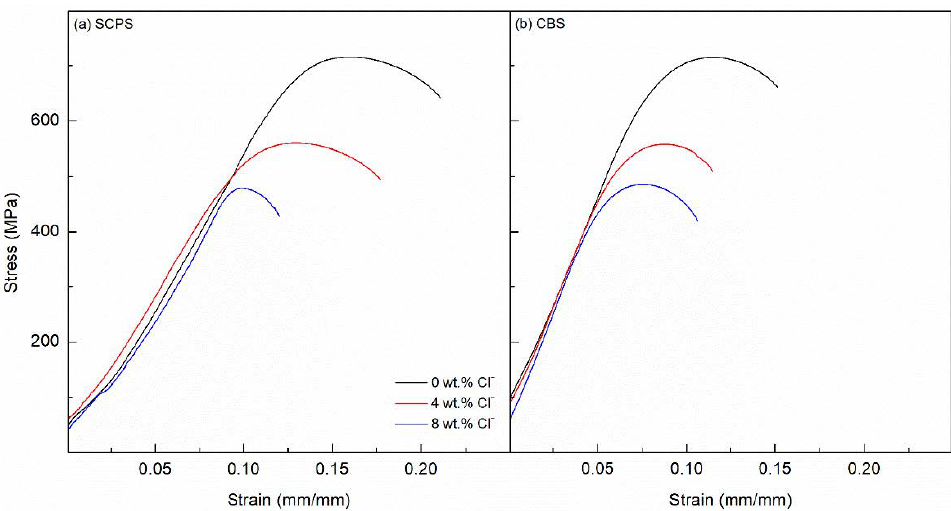
Figure 1. Microstructural characterization of as-received UNS S32205 reinforcement: ( a ) micrograph of the rolling direction ×50, and ( b ) XRD pattern and alloy phase fraction (γ‒phase and α‒phase).